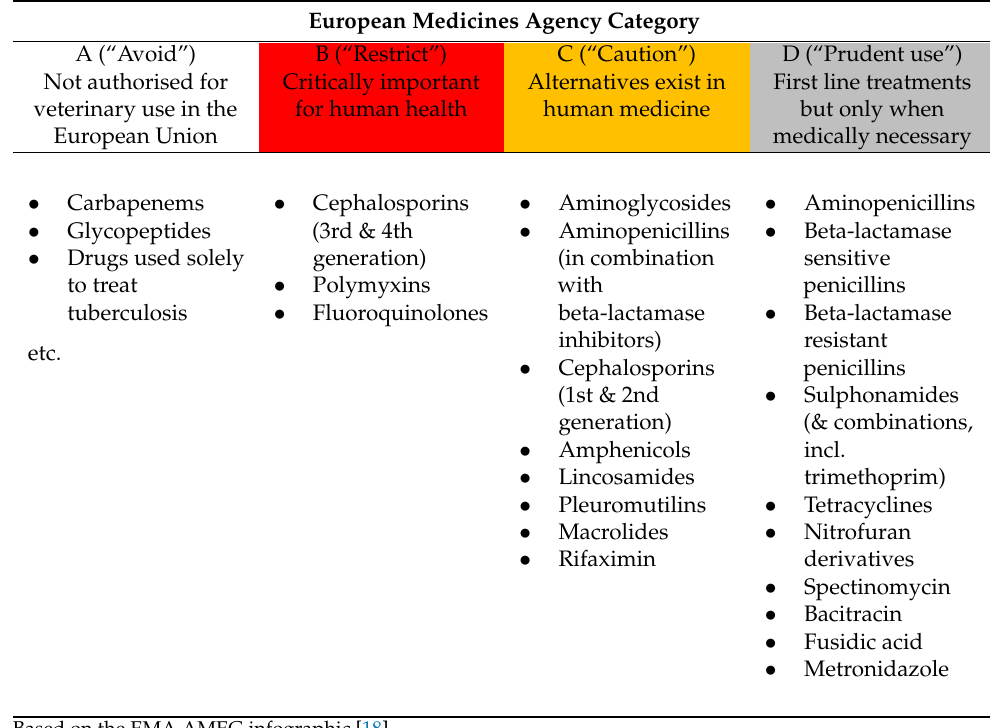
Table 4. Categorisation of veterinary antimicrobials according to the European Medicines